Question: What does this figure show? Answer in one sentence.
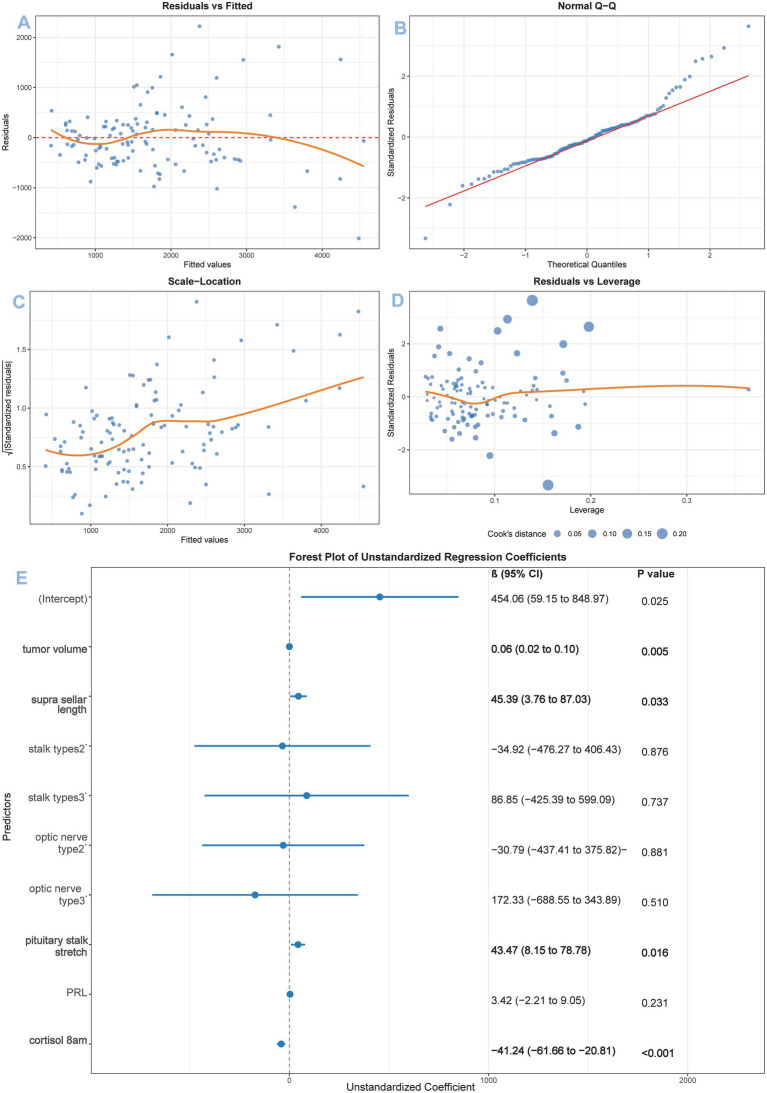
Answer: Multivariate regression analysis. (A) (Residuals vs. Fitted): Residuals are randomly distributed around the horizontal zero line, indicating no obvious linear relationship between residuals and fitted values, supporting the model’s linearity assumption. (B) (Normal Q–Q): Standardized residuals approximate the theoretical quantiles of a normal distribution, confirming the model’s normality assumption. (C) (Scale–Location): The spread of |standardized residuals| is uniform across fitted values, suggesting homoscedasticity (constant variance of residuals) is satisfied. (D) (Residuals vs. Leverage): No outliers with high leverage (leverage < 0.3) or excessive influence (Cook’s distance < 0.20) are observed, indicating the model is robust to individual data points. (E) Forest Plot of Unstandardized Regression Coefficients, The forest plot presents the unstandardized regression coefficients (β), 95% confidence intervals (CI), and p -values of predictors for glucocorticoid intensity. Asterisk represents a dummy variable set for the analysis.